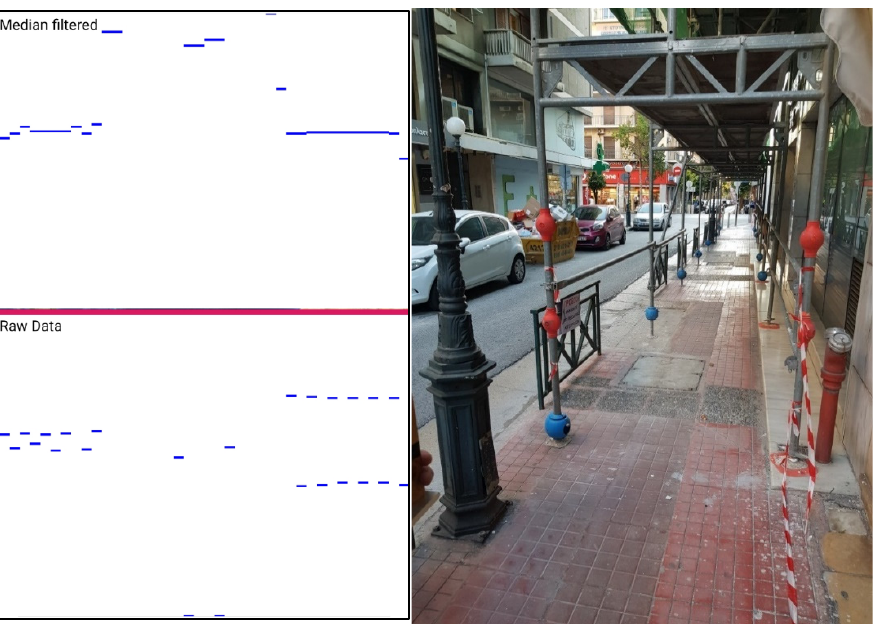
Figure 21. Response of sonar obstacle detection system.